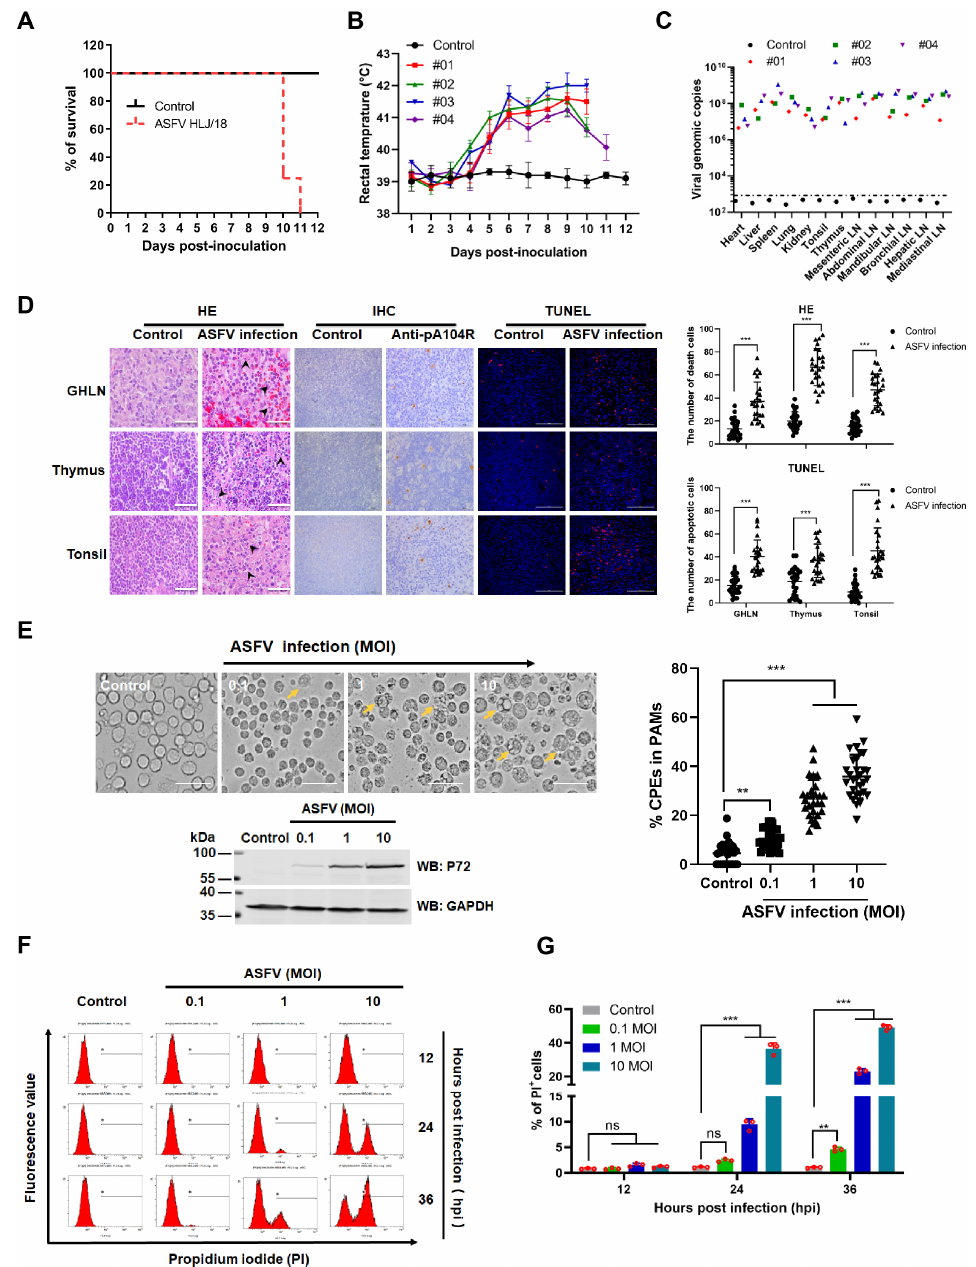
Figure 1. ASFV infection shows tissue injury and cell death in vivo and in vitro. ( A ) Survival rates. ( B ) Rectal temperature. ( C ) Viral DNA of the indicated samples was detected in the dead pigs or surviving pigs that were euthanized at 12 dpi. ( D ) Representative images of tissue sections of gastric hepatic lymph nodes (GHLNs), thymuses, and tonsils from infected or non-infected pigs. Cell death is indicated by black arrowheads in hematoxylin and eosin-stained images (HE) (scale bar: 25 μ m). Infected cells (brown) were stained by immunohistochemistry (IHC) with anti-ASFV monoclonal antibody (pA104R) (scale bar: 50 μ m) and apoptotic cells were labeled with TUNEL (red) (scale bar: 100 μ m). Death or apoptotic cells from 25 fields of 5 random tissue sections were counted under a 40× objective and the results (right) are shown as mean ± SD values, n = 25. The significance of the differences between the groups was determined by an unpaired t -test with Welch’s test with 2-tails (*** p < 0.001). ( E ) Representative images of cytopathic effects (CPEs) caused by ASFV infection in PAMs. PAMs were non-infected or infected with ASFV HLJ/18 at MOIs of 0.1, 1, or 10 for 36 h and then visualized under a microscope (left). Yellow arrows indicate CPEs. Scale bar, 10 μ m. The right panels show the statistical results regarding the percentage of CPEs. CPEs from 10 fields (approxi-